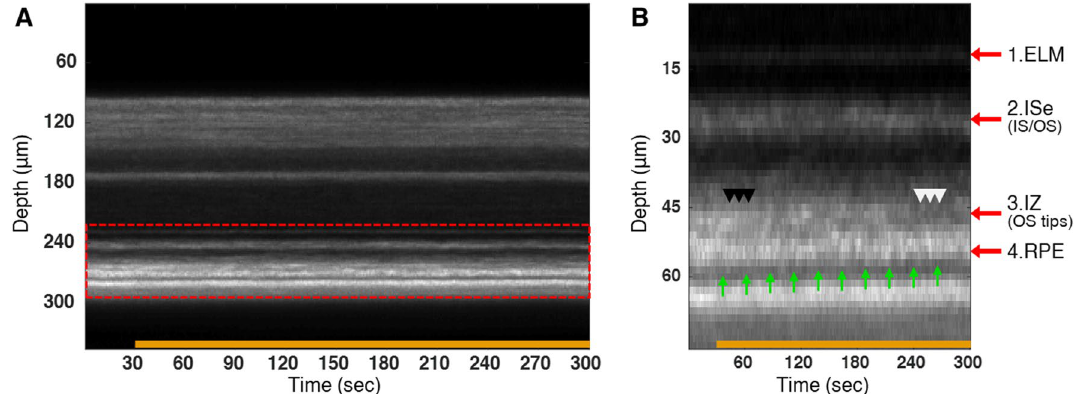
Figure 5. High-speed OCT recording during the light–dark transition. The lights were off at 30 s. ( A ) Spatiotemporal mapping of OCT images. Each column represents a 1-s recording. ( B ) Enlarged view of the red box in ( A ). Black and white arrowheads point out the 3rd band change during dark adaptation. Green arrows indicate basal RPE position. ELM external limiting membrane, ISe inner segment ellipsoid, IS inner segment, OS outer segment, IZ interdigitation zone, RPE retinal pigment epithelium, CH